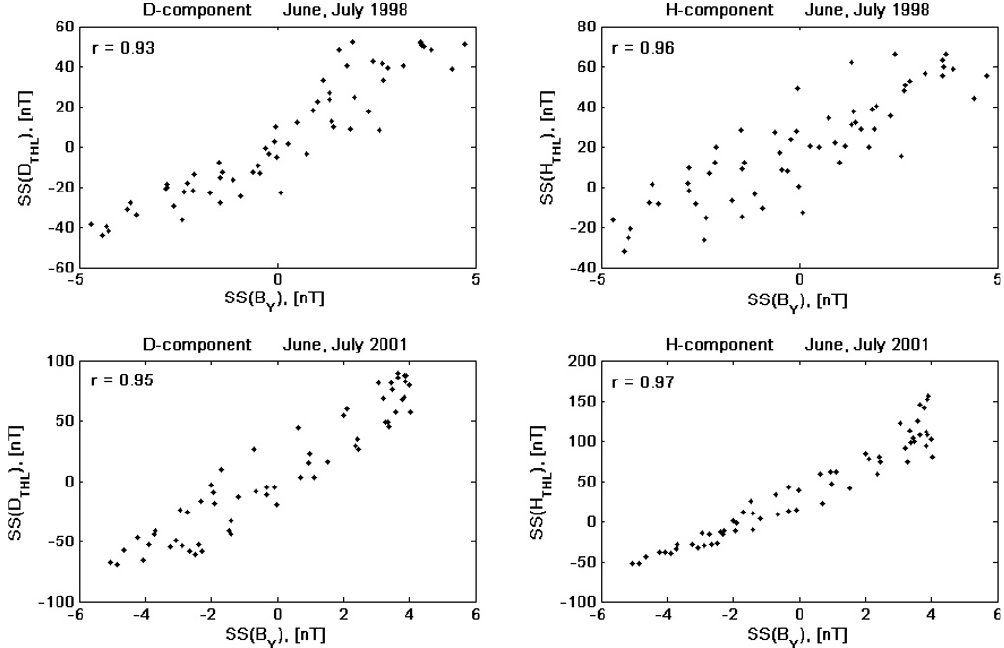
Fig. 8. The relationship between the satellite and ground-based sets of magnetic data on variations caused by the IMF sector structure in the summer months of 1998 (upper row) and 1991 (lower row) for geomagnetic D (left column) and H (right column) components at